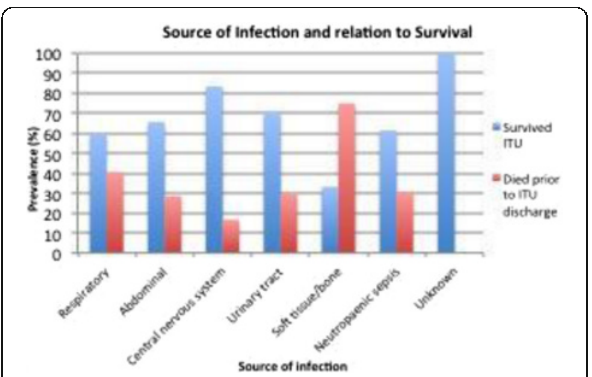
Fig. 43 (abstract A112). Source of Infection and